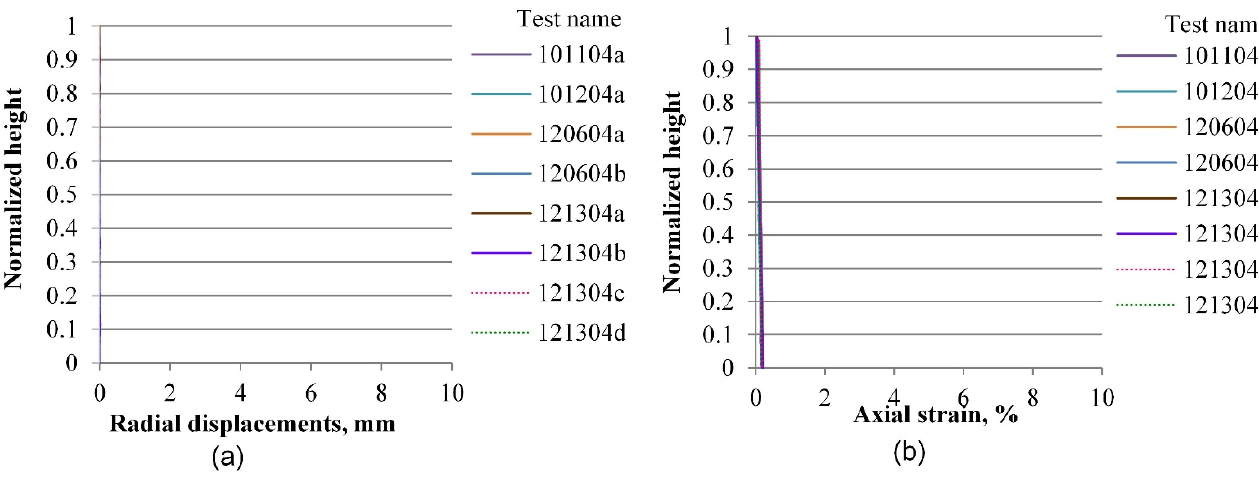
Figure 20. Vertical profiles of averaged displacements at 0.2% of the axial strain of sand specimens